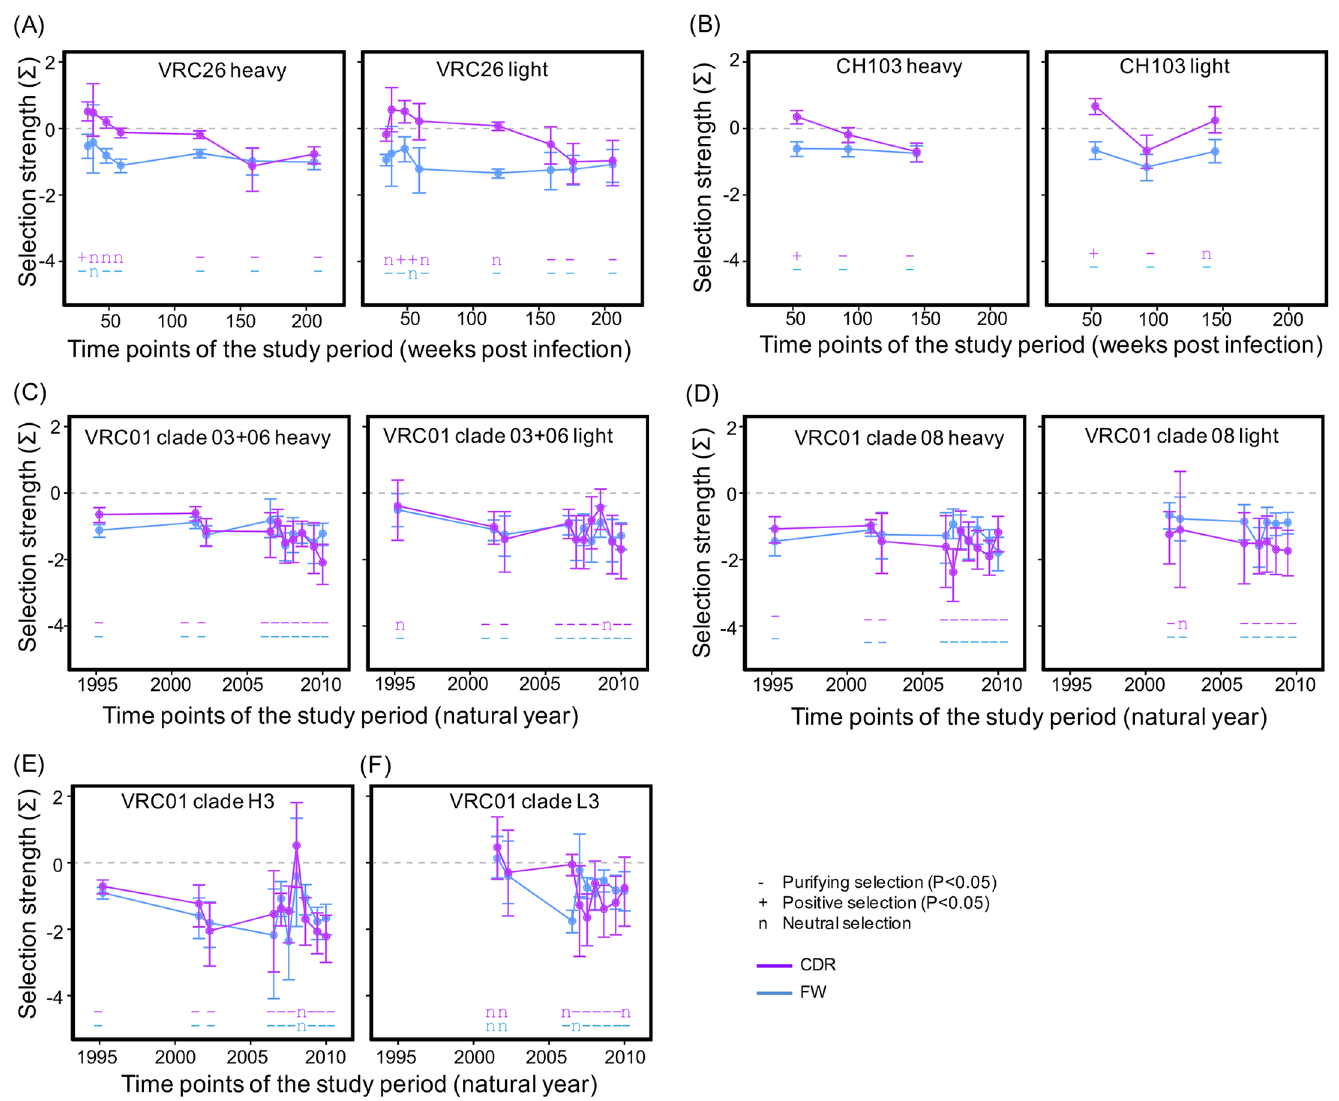
Fig 6. Selection pressure dynamics for all time points of the three lineages. (A) Selection pressure changes of the VRC26 lineage heavy (left) and light (right) chains. (B) Selection pressure changes of the CH103 lineage heavy (left) and light (right) chains. (C) Selection pressure changes of the VRC01 clade 03+06 heavy (left) and light (right) chains. (D) Selection pressure changes of the VRC01 clade 08 heavy (left) and light (right) chains. (E) Selection pressure changes of the VRC01 clade H3. (F) Selection pressure changes of the VRC01 clade L3. The selection strength for each time point of a lineage chain was measured using BASELINe. The same datasets used for evolutionary rate calculation were used to calculate selection strength. The mean and 95% HPD interval of selection strength for the CDRs (magenta) and FWRs (blue) were calculated separately. The statistical significance of the measured selection strength is shown on the bottom of the plot with ‘ - ’ , ‘ + ’ and ‘ n ’ denoting negative selection, positive selection, and neutral selection, respectively.